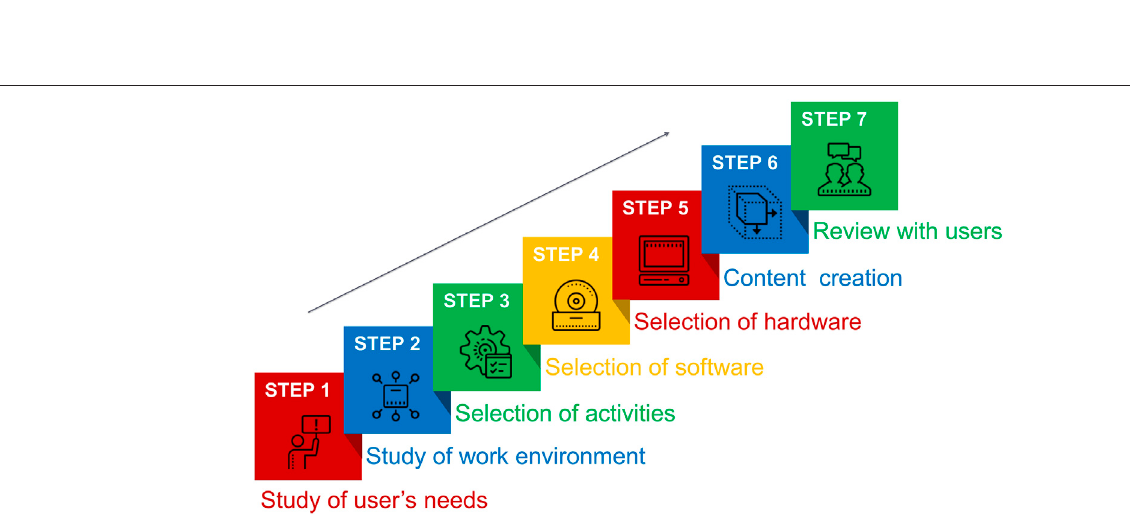
FIGURE 6 | List of tasks conducted during the overhaul maintenance process.